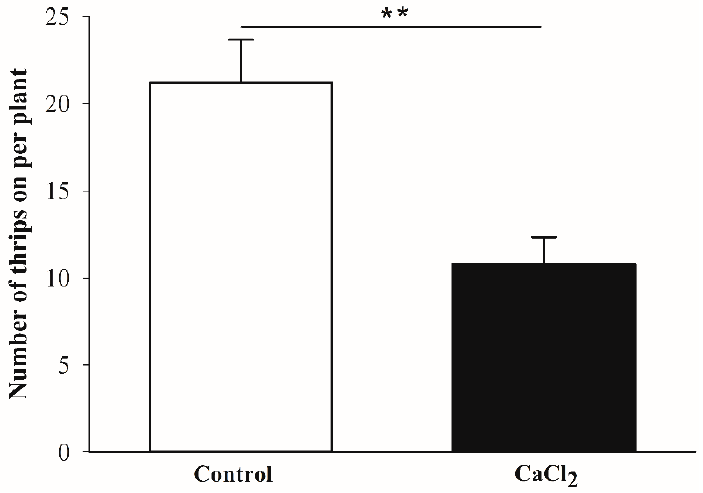
Figure 5. Number of adult female Frankliniella occidentalis found on control and exogenous Ca-treated